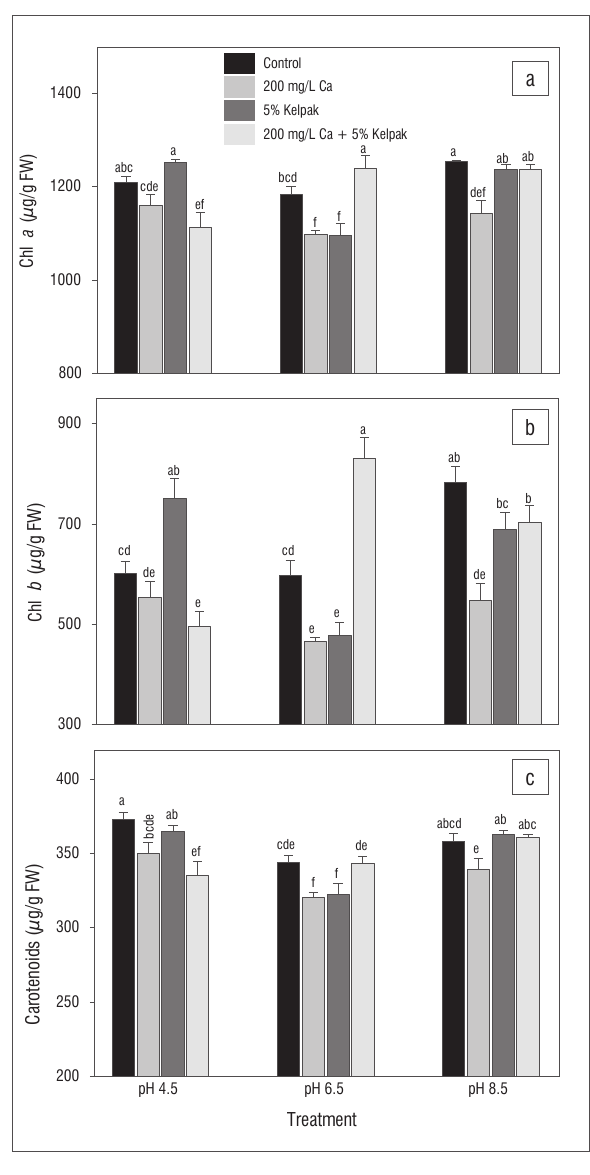
Figure 4: Effect of pH, water hardness (Ca 2+ concentration) and 5% Kelpak on (a) chl a , (b) chl b and (c) carotenoid content of Swiss chard grown in pots. Letters above bars indicate significant differences (mean±SE where n =6; p <0.05) obtained when data was analysed using Duncan’s Multiple Range